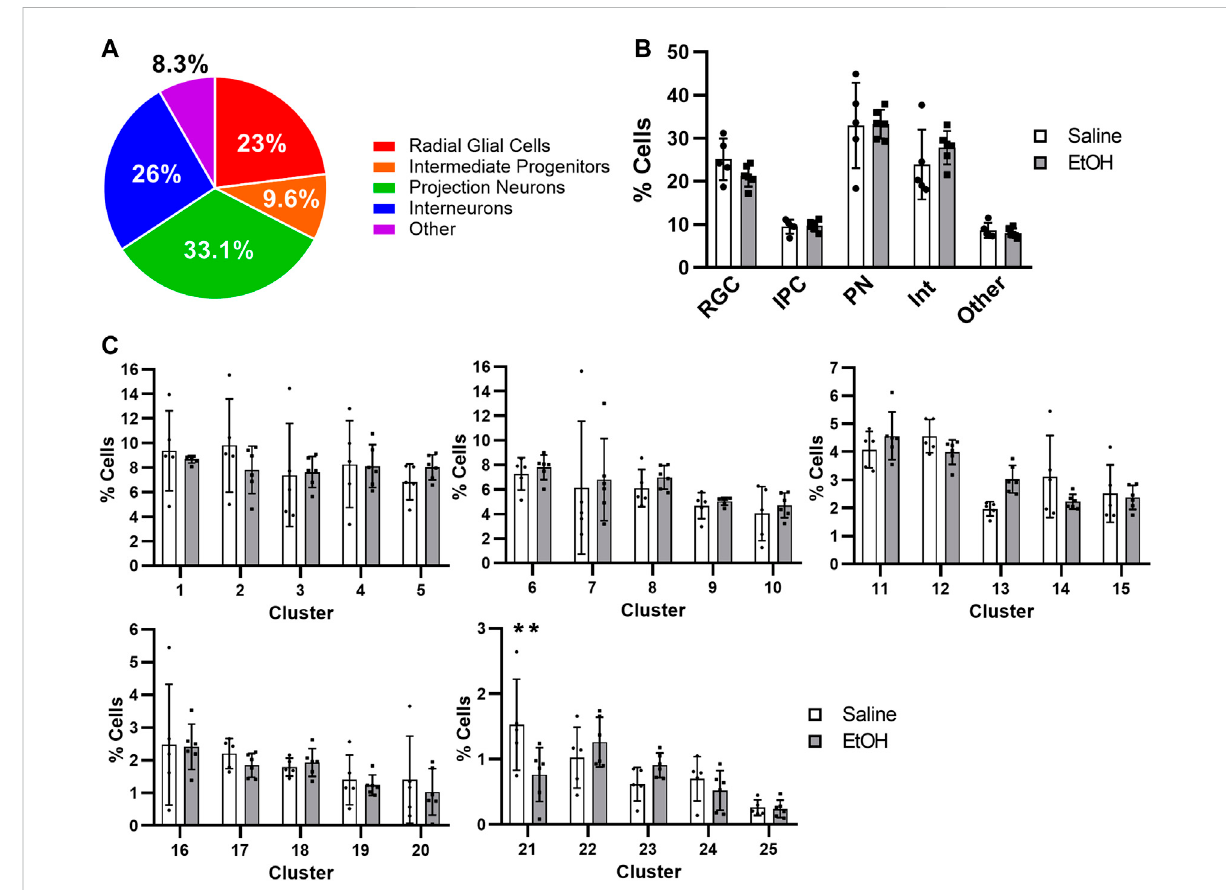
FIGURE 2 Distributionofcellacrosscelltypes. (A) Piechartofthepercentageofmajorcelltypesacrossallsamples. (B) Bargraphofthepercentageofcells in each major cell type comparing saline and EtOH. (C) Bar graphs of the percentage of cells for each cluster comparing saline and EtOH. The 25 clusters were grouped in cohorts of 5. ANOVA **: p -value < 0.01.